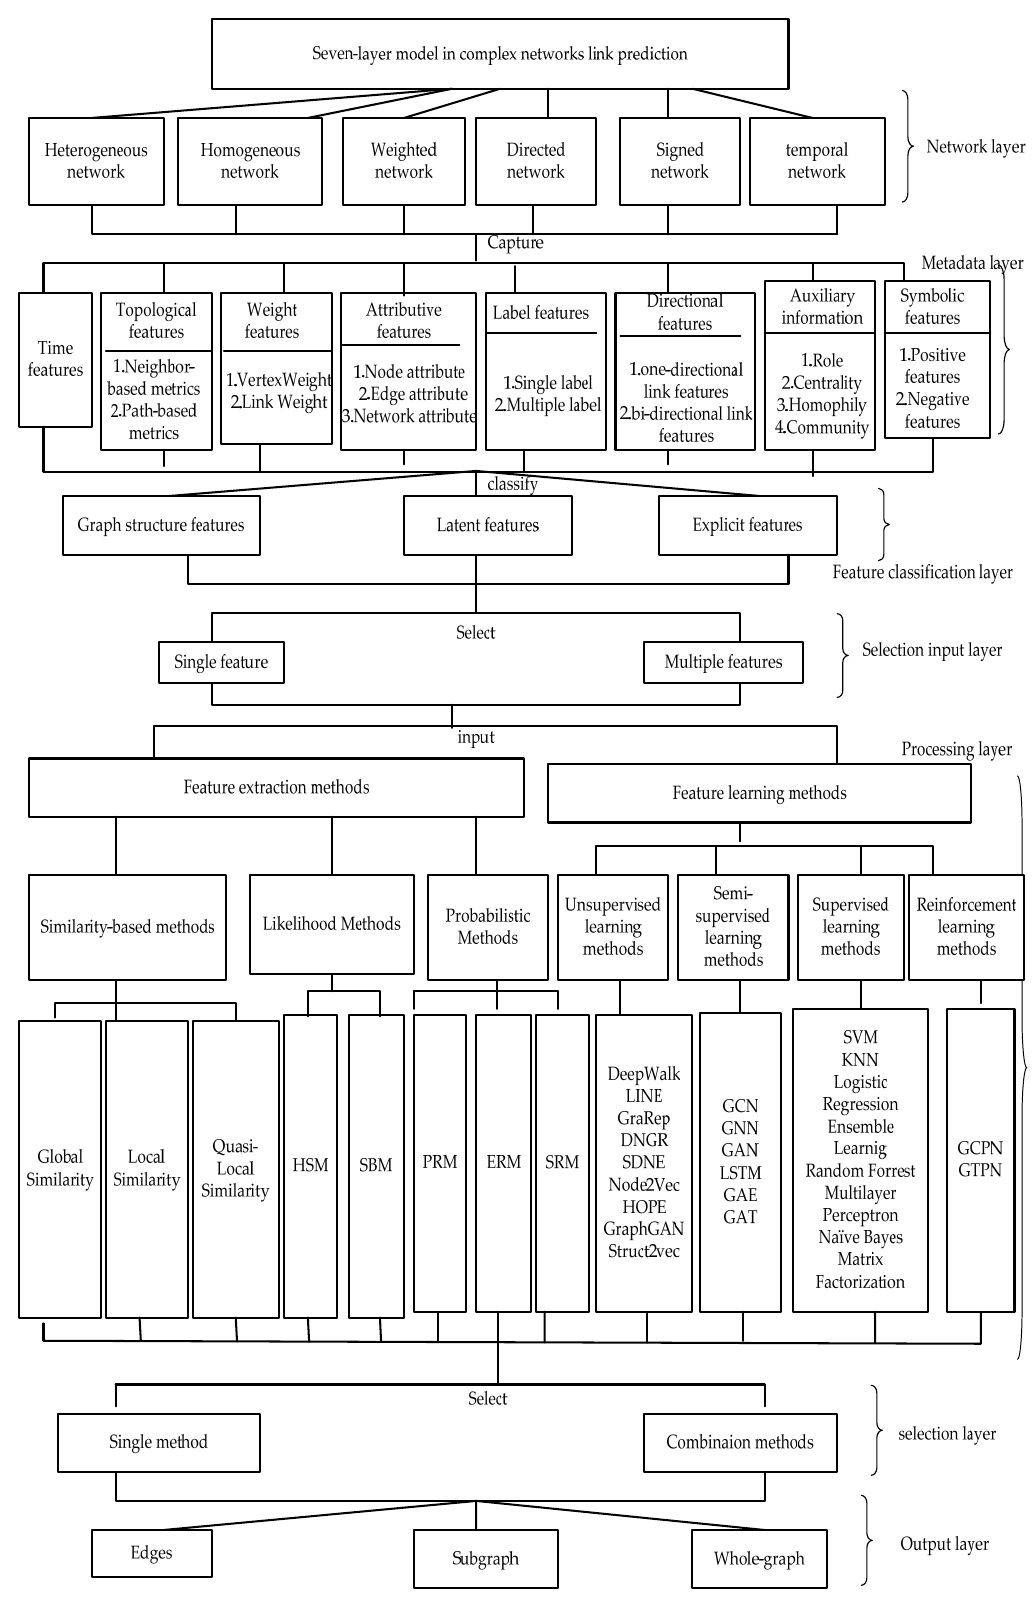
Figure 5. Seven-layer model in complex networks link prediction.